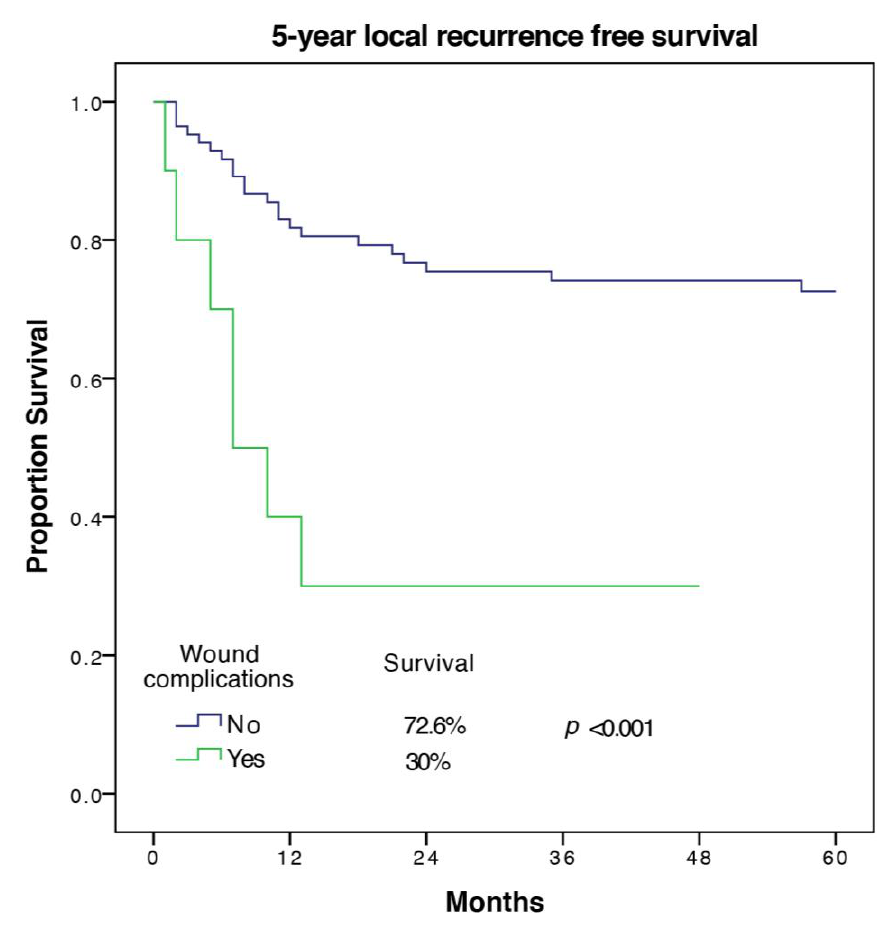
Figure 1. 5-year local recurrence free survival of patients with and without wound complications.